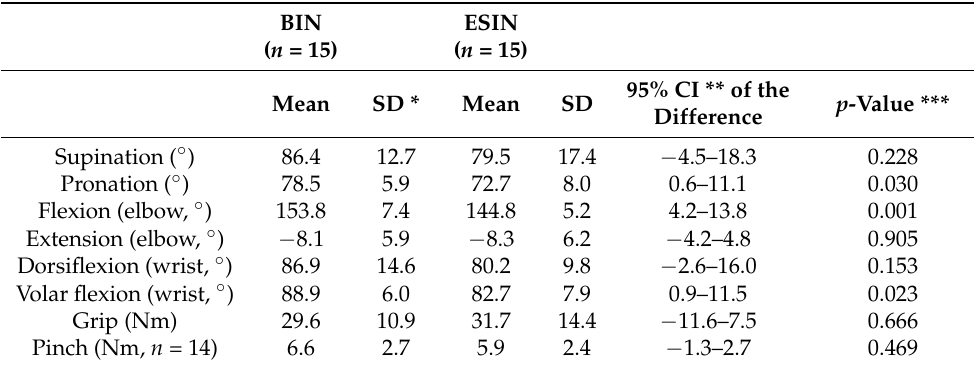
Table 2. Functional results of the upper extremity at mean 6.8 years after forearm fracture operation using Biodegradable Nail (BIN) or Elastic Stable Intramedullary Nail (ESIN). BIN ESIN ( n = 15) ( n =